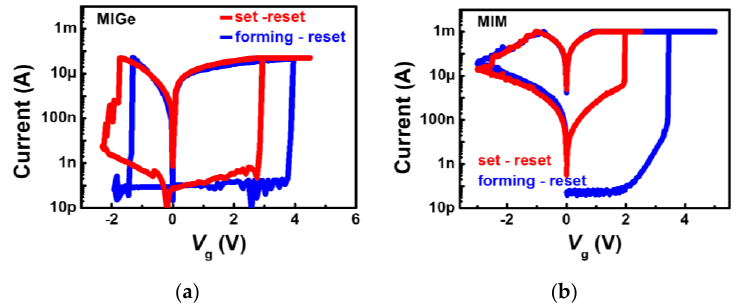
Figure 2. DC I - V g curves of ( a ) Pd/HfO x /p-Ge devices and ( b ) TiN/HfO x /Pt devices.